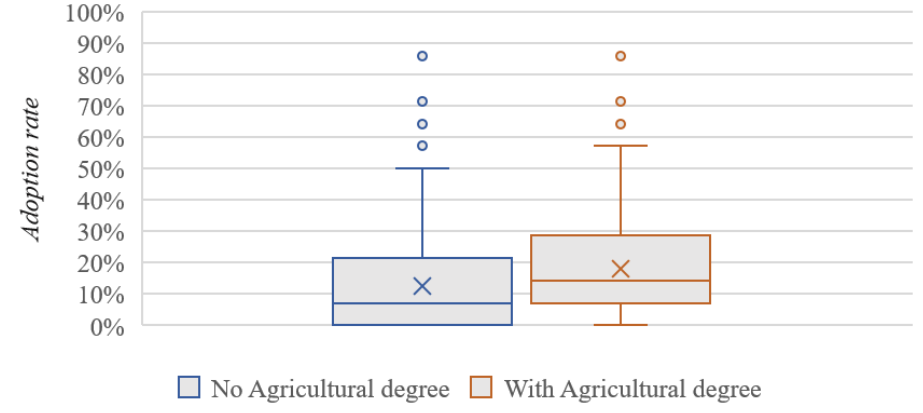
Figure 9. Boxplot graph of adoption level and type of